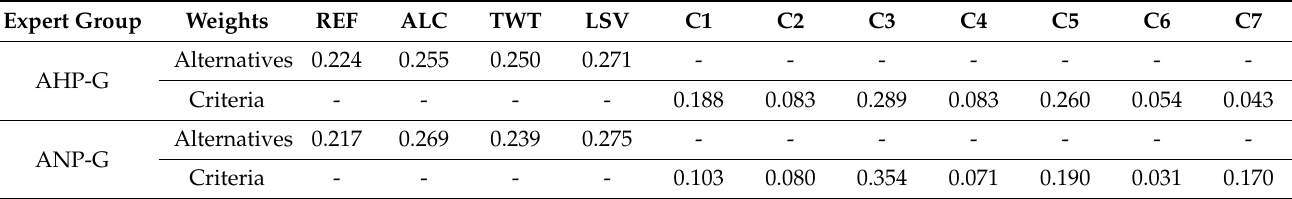
Table 10. Comparison of the results of the AHP group vs. the ANP